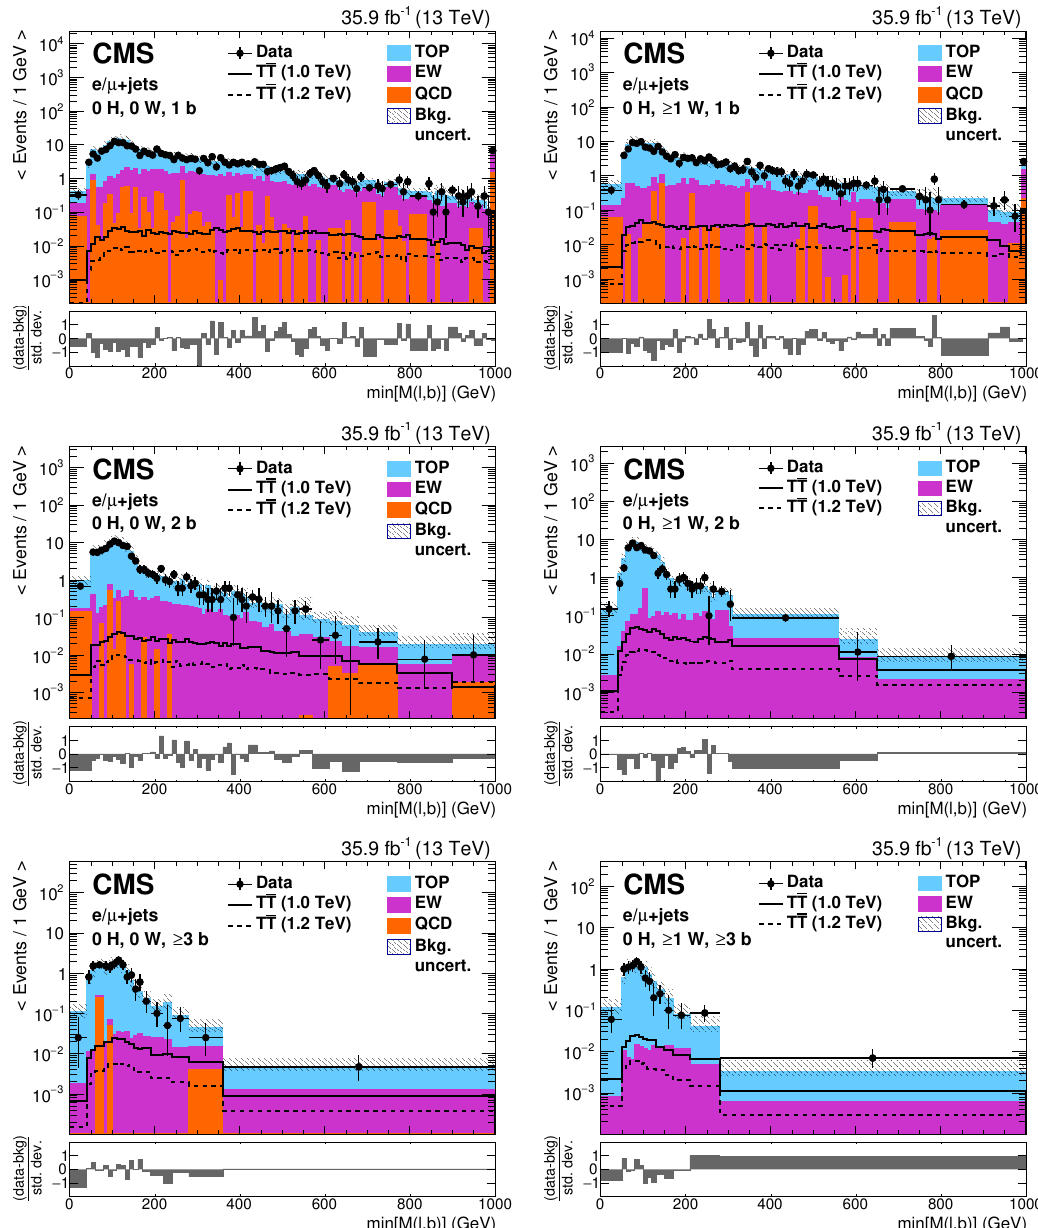
Figure 5 . Distributions of min[ M ( ‘; b)] before the (cid:12)t to data in the single-lepton W0 (left) or W1 (right) categories with 1, 2, or 3 (upper to lower) b-tagged jets. The black points are the data (cid:21) (horizontal bars indicate the bin width) and the (cid:12)lled histograms show the simulated background distributions, grouped into categories as described in section 3. The expected signal is shown by solid and dotted lines for T quark masses of 1.0 and 1.2 TeV. The (cid:12)nal bin includes over(cid:13)ow events. Uncertainties, indicated by the hatched area, include both statistical and systematic components The lower panel shows the di(cid:11)erence between data and background divided by the total uncertainty.